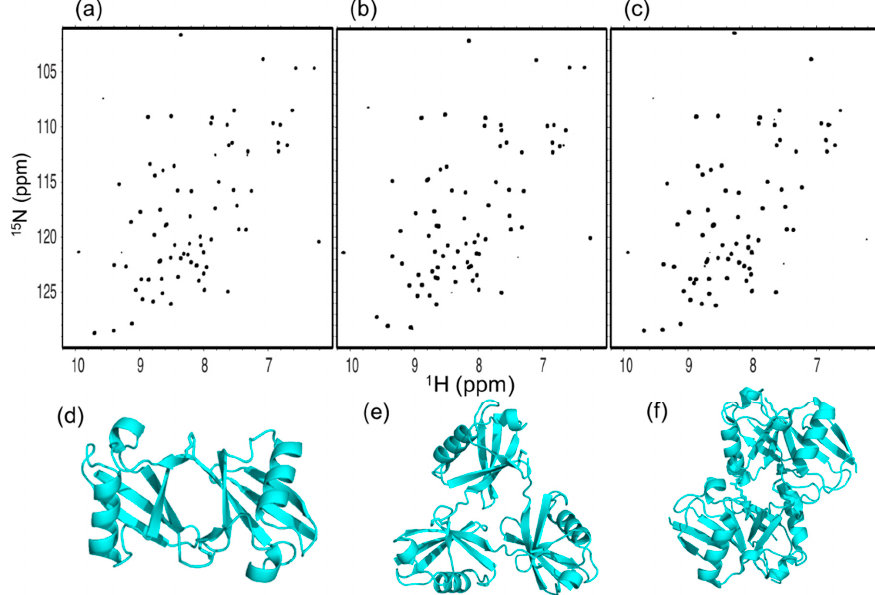
Figure 2. Schematic diagram of the preparation of native and cyclic forms of Lys48-linked Ub chains.